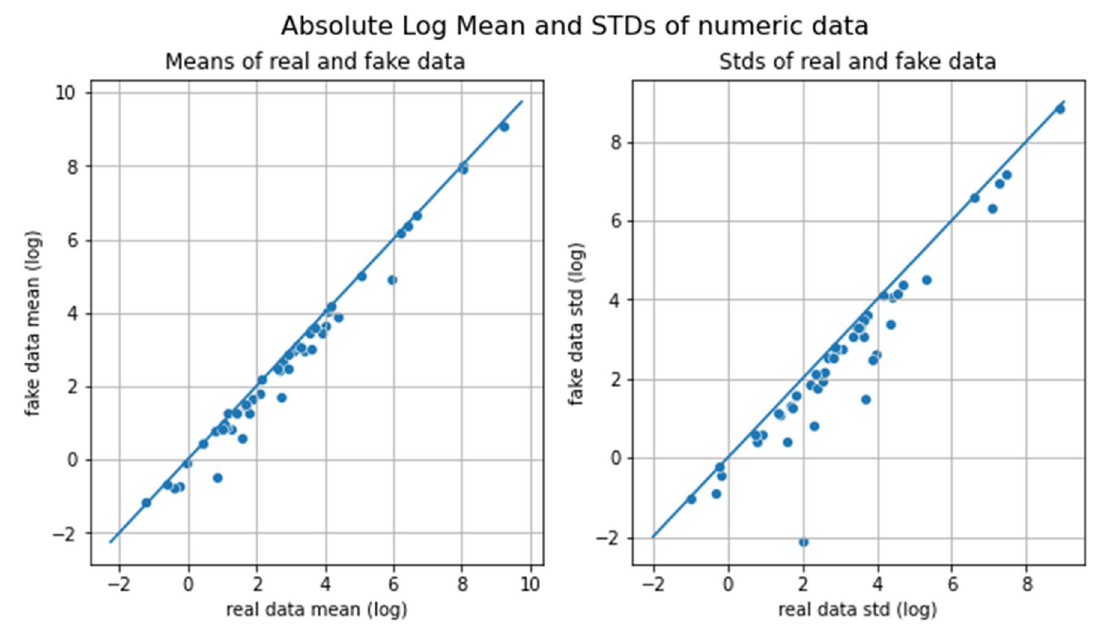
Figure 5. Each point represents a column mean in the real and synthetic data. A perfect match would be indicated by all the points lying on the line y =